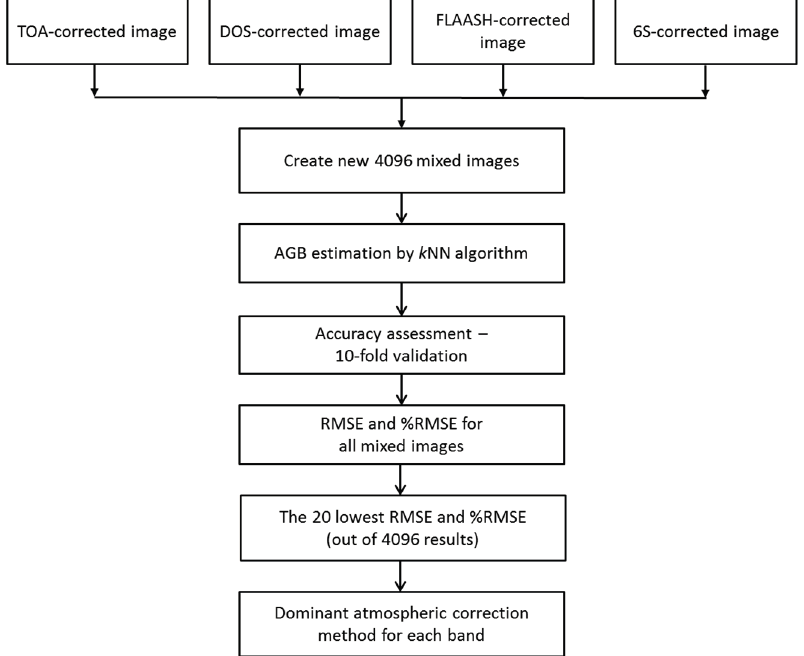
Figure 4. Matlab routine for finding dominant atmospheric correction method for each